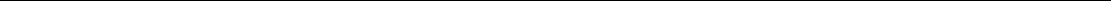
Fig. 2 Gene products of MAGI2 , TNS2 , DLC1 , CDK20 , and CAV1 physically and functionally interact to regulate RhoA/Rac1/Cdc42 activation. a Identi fi cation of six novel monogenic causes of NS reveals a regulatory network of RhoA activation. The large rounded square symbolizes a podocyte. All six proteins MAGI2, TNS2, DLC1, CDK20, ITSN1, and ITSN2, in which recessive defects were detected herein as novel causes of pTSNS, interact physically or functionally to regulate RhoA/Rac1/Cdc42. Yellow labels highlight proteins encoded by genes, which if mutated give rise to monogenic nephrosis as shown in this study (MAGI2, TNS2, DLC1, CDK20, ITSN1, and ITSN2) or as published (EMP2, ARHGDIA). Blue frame around yellow labels indicate that there is also a monogenic mouse model of NS or a zebra fi sh model known, as shown in this study for ITSN2 or as published for MAGI2, TNS2, EMP2, and RhoGDI- α . For each of the proteins, MAGI2, TNS2, DLC1, CDK20, TLN1, or ITSN1, the protein domains are shown. Red circles denote positions of mutations that we found in patients. Truncation mutations are represented by “ x ” . By identifying novel monogenic causes of NS we discovered a cluster proteins that regulate Rho/Rac/Cdc42 activation as being central for the pathogenesis of these patients. b MAGI2 interacts with TNS2 upon co-overexpression and coimmunoprecipitation (coIP) in HEK293T cells. Both mutant MAGI2 clones, Gly39* and Tyr746* (underlined) that re fl ect alleles of NS patients A5146-21 and B91 respectively, abrogate this interaction. c MAGI2 interacts with DLC1 upon co-overexpression and coIP in HEK293T cells. One mutant MAGI2 clone Gly39* (underlined) re fl ecting a mutation of NS patient A5146-21 abrogates this interaction. d DLC1 interacts with CDK20 upon co-overexpression in HEK293T cells. e DLC1 interacts with CAV1. Two mutant DLC1 c-DNA clones, re fl ecting Trp10* and Lys1358Thr alleles of NS patients A548-21 and A4967- 21 respectively, lack this interaction. f In IMCD3 cells, migration rate is induced in the presence of serum as compared to scrambled control. Knockdown of Dlc1 in IMCD3 cells using mouse Dlc1 siRNA #1 impairs cell migration rate (red vs. black curve with serum). The decrease in migration is rescued by transfection with full-length human DLC1 cDNA (green curve). Transfection with four out ot six mutants (Trp10*, Ala456Val, Ala1352Val, and